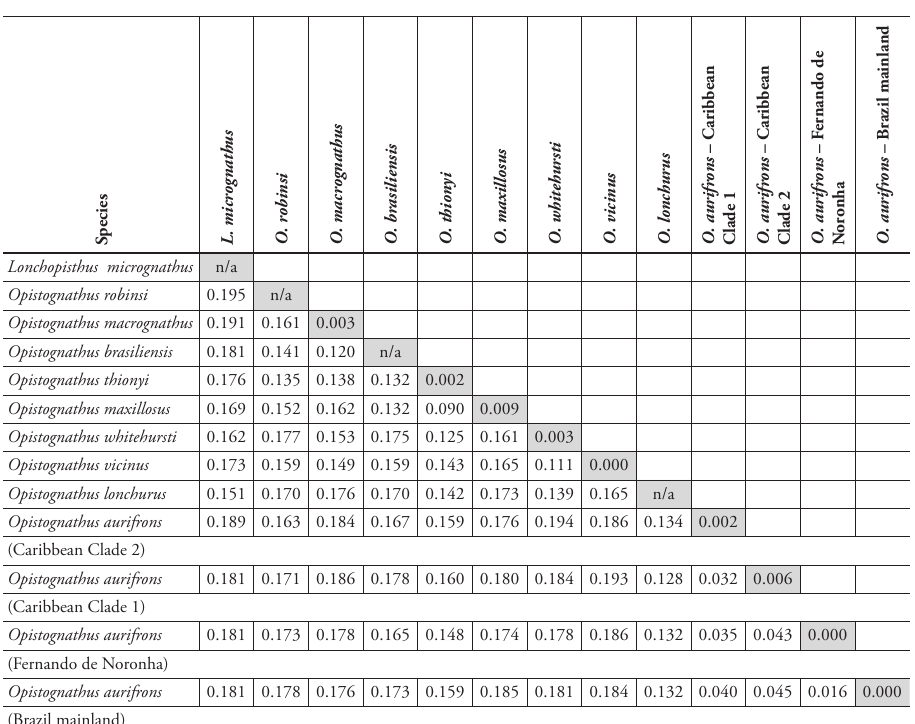
Table 2. Mean between-group p-distances. Shaded values on the diagonal are mean within-group p- distances for groups with more than one sequence. The number of base differences per site from averag- ing over all sequence pairs between groups are shown. The analysis involved 103 nucleotide sequences. Codon positions included 1st+2nd+3rd+noncoding. All positions containing gaps and missing data were eliminated. There are a total of 103 positions in the final dataset. Evolutionary analyses were conducted in MEGA7 [1]. Caribbean Clade 1 = Florida, Bahamas, Caribbean; Caribbean Clade 2 = Aruba and